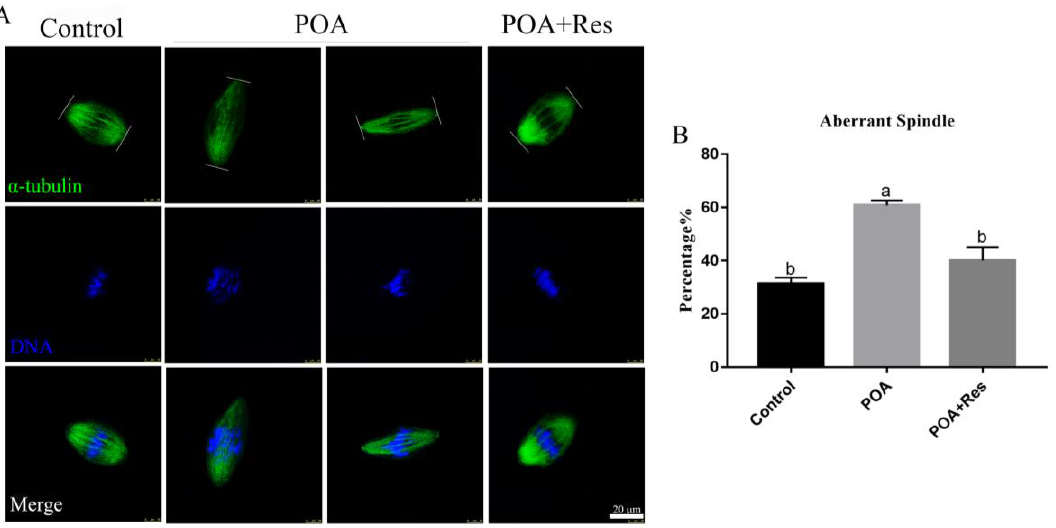
Figure 4. Resveratrol maintains correct spindle assembly and morphology in POA oocytes. ( A ) Representative images of spindle assembly in the control, POA and resveratrol-treated POA (POA + Res) oocytes. Images of spindle (green) and DNA (blue) were observed by the confocal microscopy. Scale bar = 20 μm. ( B ) The percentages of the aberrant spindles in the control, POA, and POA + Res groups. Data are presented as mean ± SEM from at least three independent experiments. a,b means not sharing a common superscript is different ( P < 0.05).